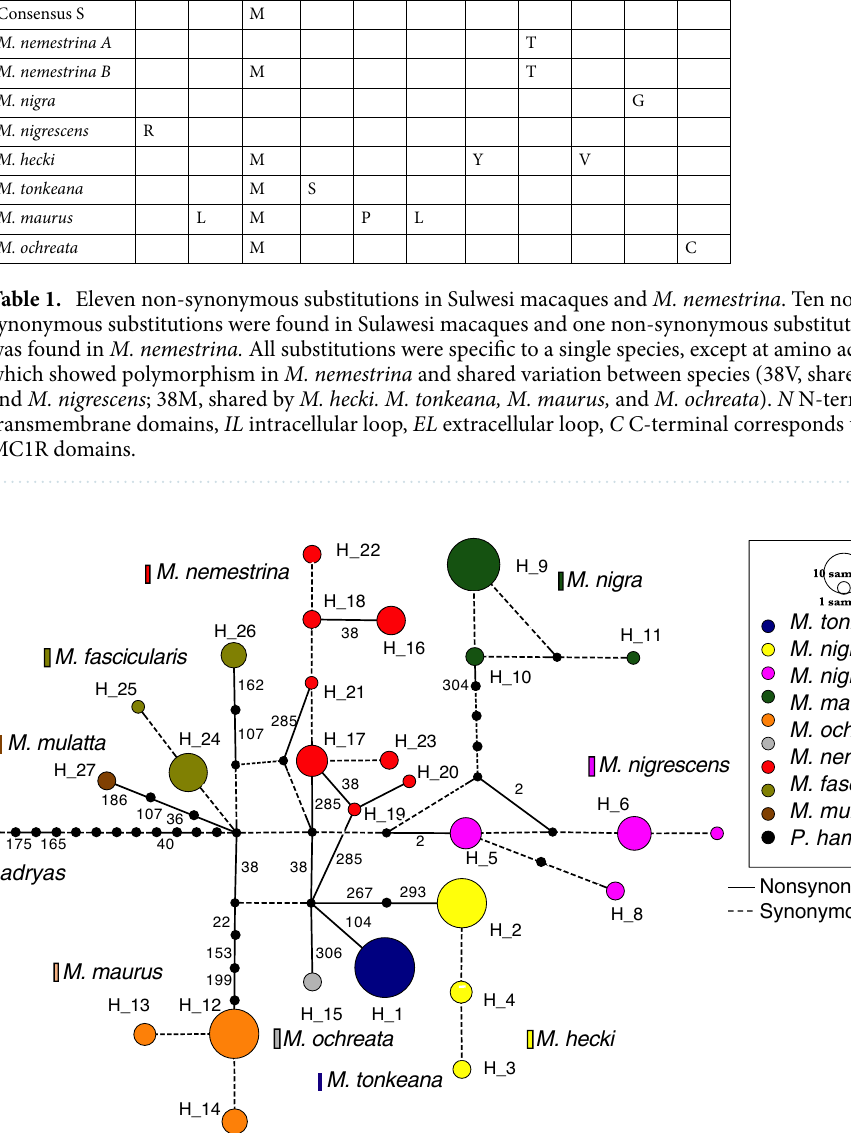
Figure 2. Haplotype network for MC1R in Sulawesi macaques, M. nemestrina , M. fascularis , and M. mulattta. P. hamadryas was used as the outgroup. Each circle represents a distinct nucleotide haplotype. The size of a circle is proportional to the allele frequency. Each color represents a different species. Every mutation (nucleotide substitution) is shown as a 1-step edge. Line styles indicate the mutation type. Positions of non-synonymous substituions are indicated on the network